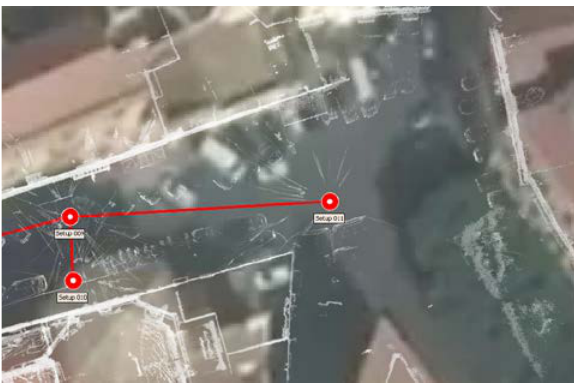
Figure 3. Survey station used for facade reconstruction